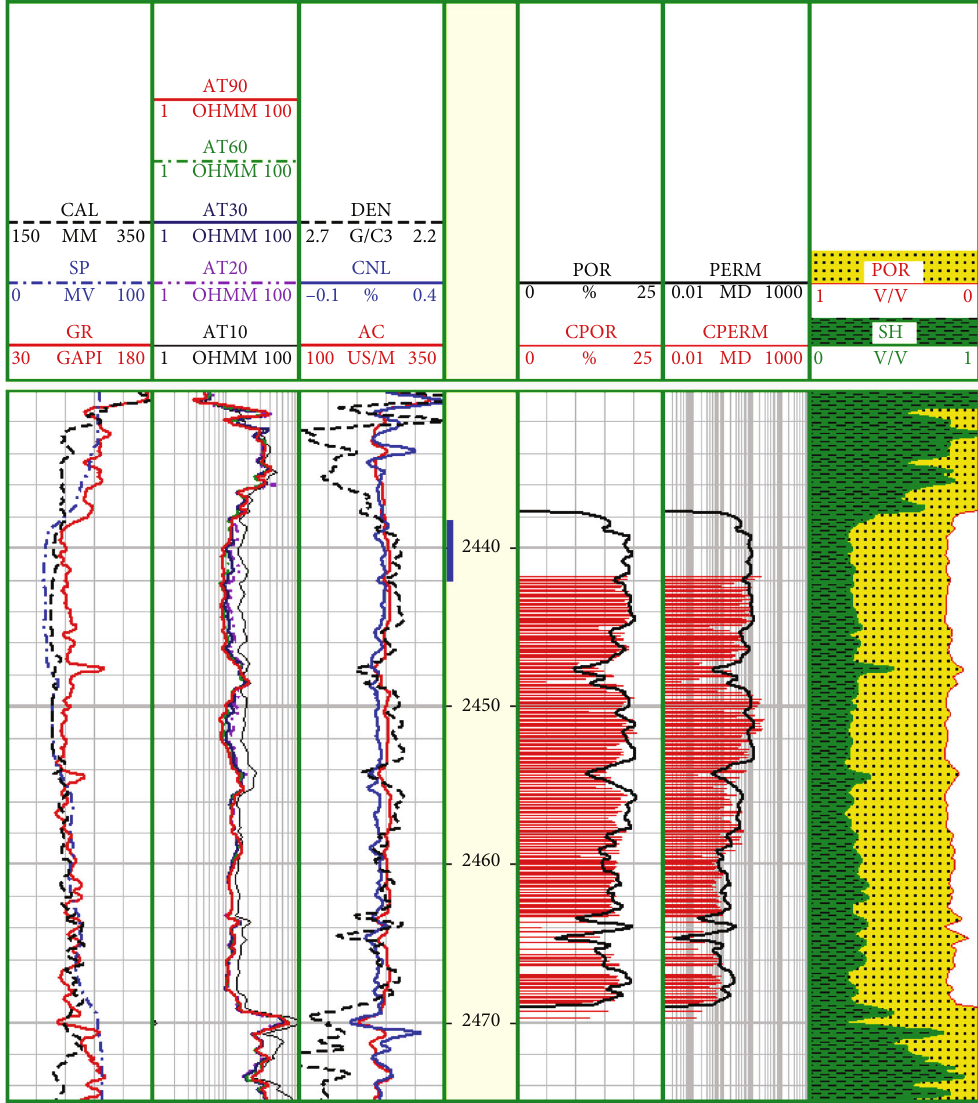
Figure 4: Water layers in Well M1. The resistivity is about 8 ~ 10 Ω ·